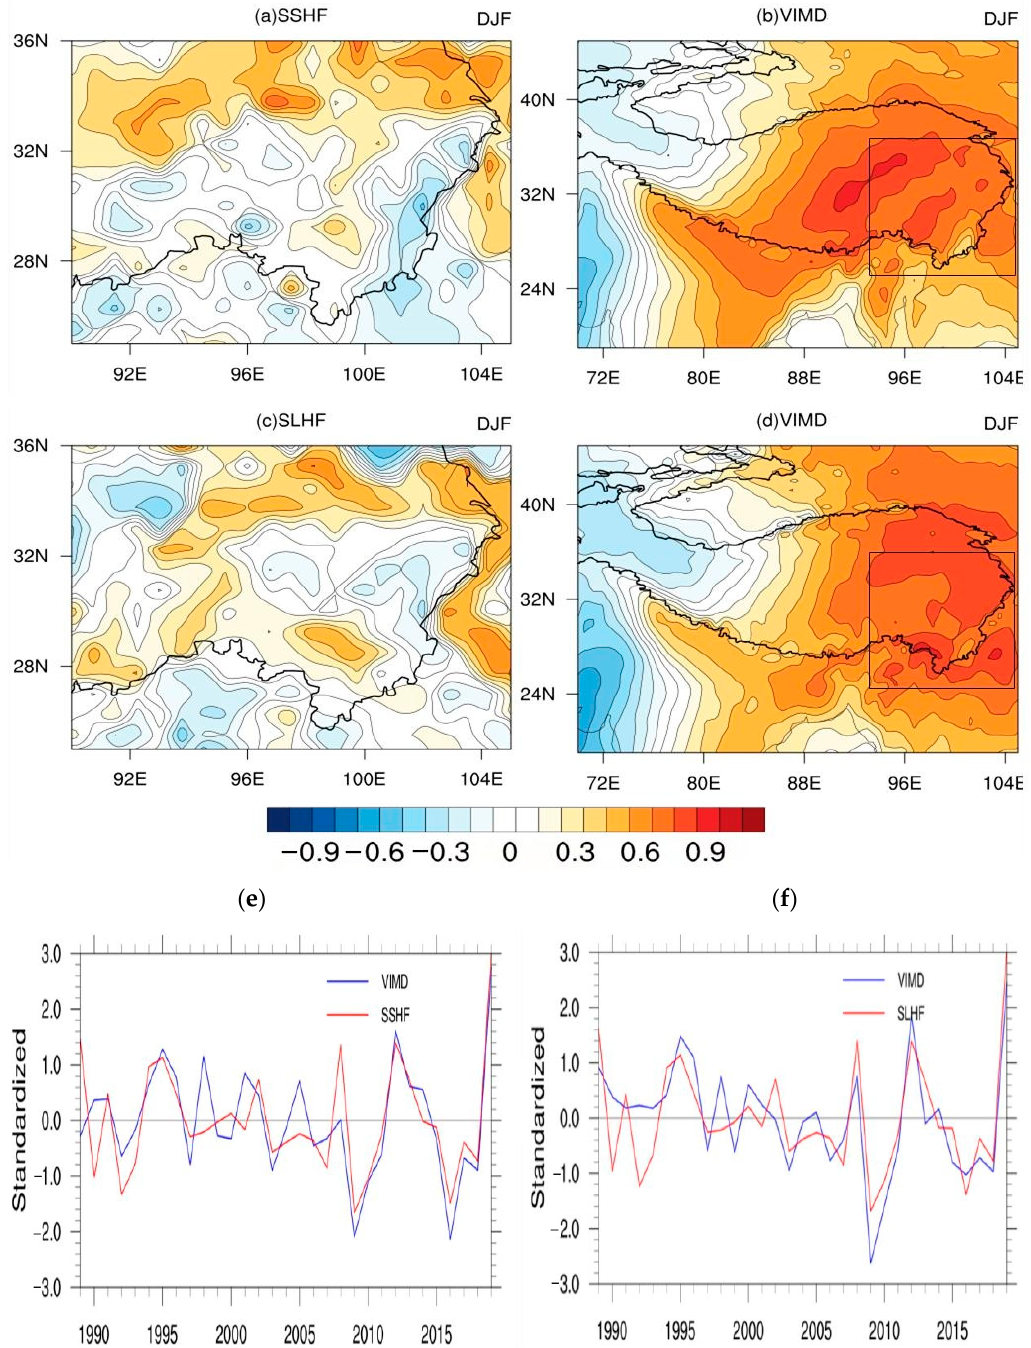
Figure 8. ( a – d ) SVD analysis and ( e , f ) corresponding time series of the surface flux field and northward water vapor flux field in southeastern Tibet during the non-AMS. ( a ) the first mode of the thermal field; ( b ) the first mode of the northward water vapor flux field; ( c ) the first mode of the latent heat field; ( d ) the first mode of the northward water vapor flux field; ( e ) the sensible heat flux and northward water vapor flux field; and ( f ) the latent heat flux and northward water vapor flux field. The solid black line is the boundary of the Tibetan Plateau in ( a – d ). The solid red line is SSHF time series and the solid blue line is VIMD in ( e , f ) time series.